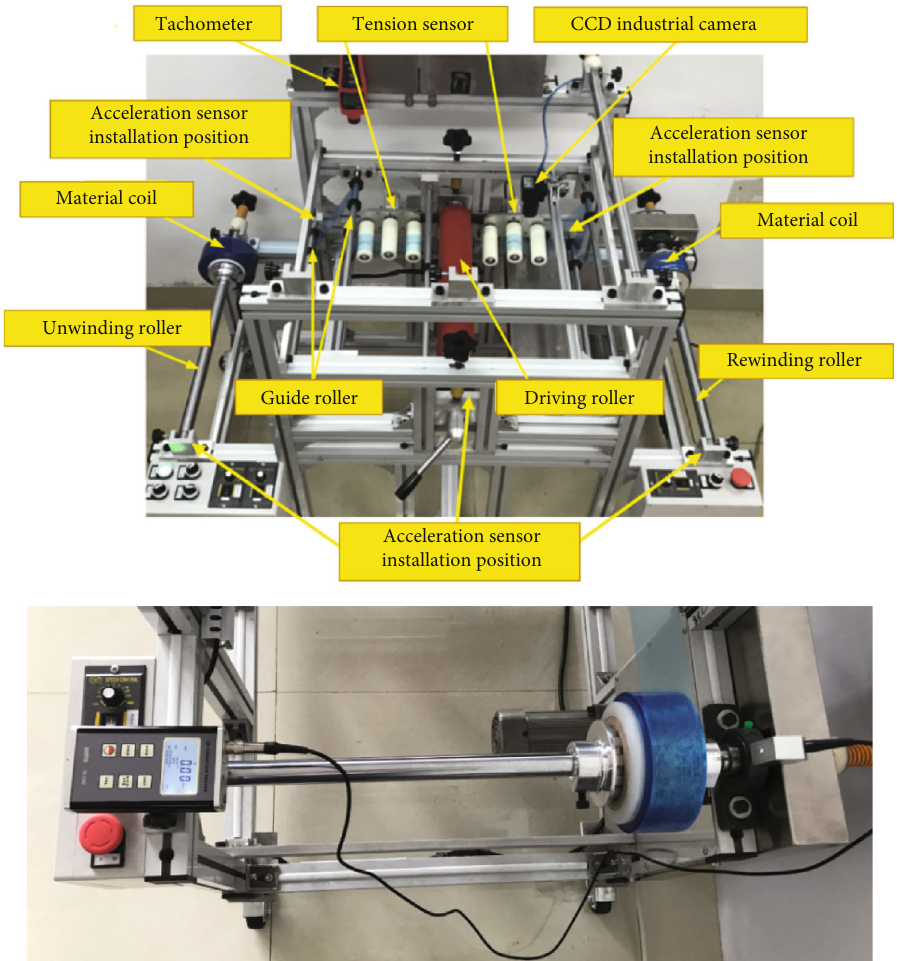
Figure 2: Flexible material roll-to-roll processing